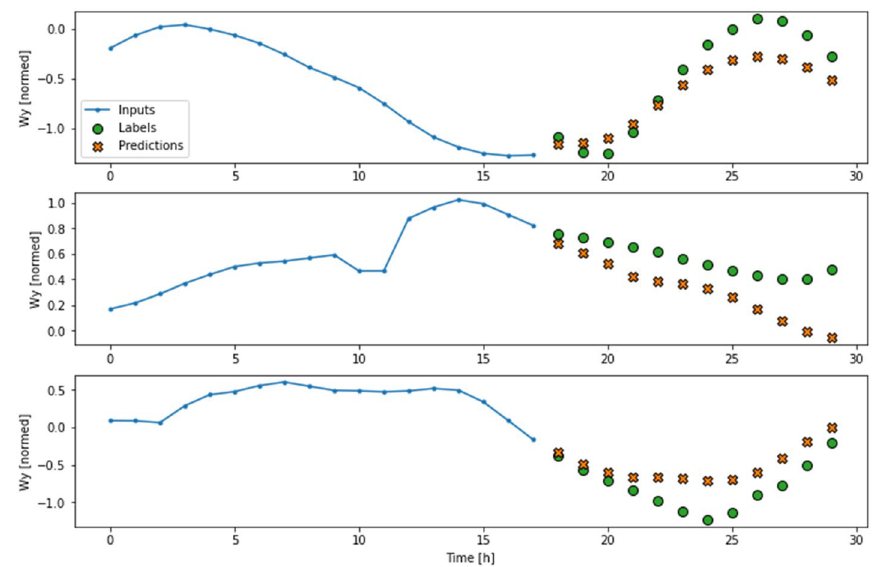
Fig. 23 W y forecast for 12 h on three portions of the test set